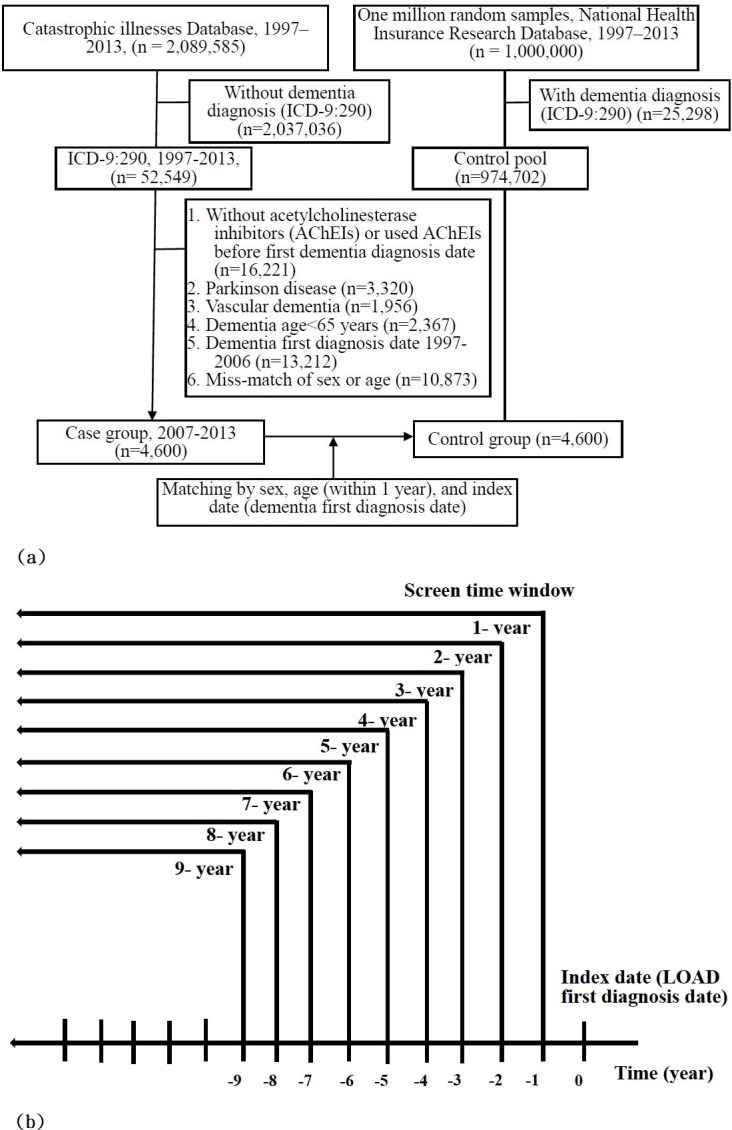
(a) Flowchart of subject selection process; (b) screen time windows used to identify prior diseases associated with LOAD.